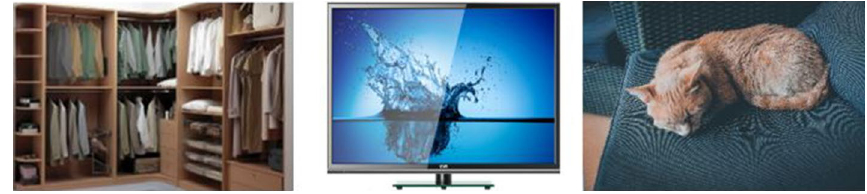
Fig. 1 Association activity for the hyperonym “furniture”—hyponym